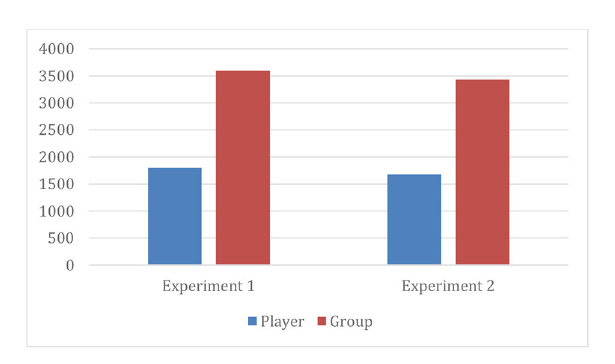
FIGURE2 Average total contributions.